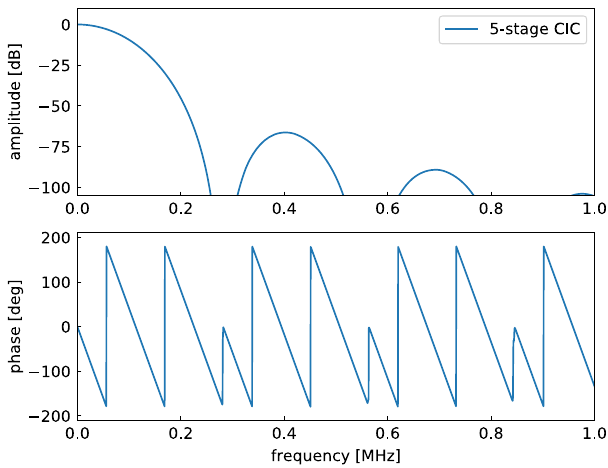
FIG. 7. Amplitude and phase responses of the five-stage CIC filter where R ¼ 2 , M ¼ 256 , and N ¼ 5 .